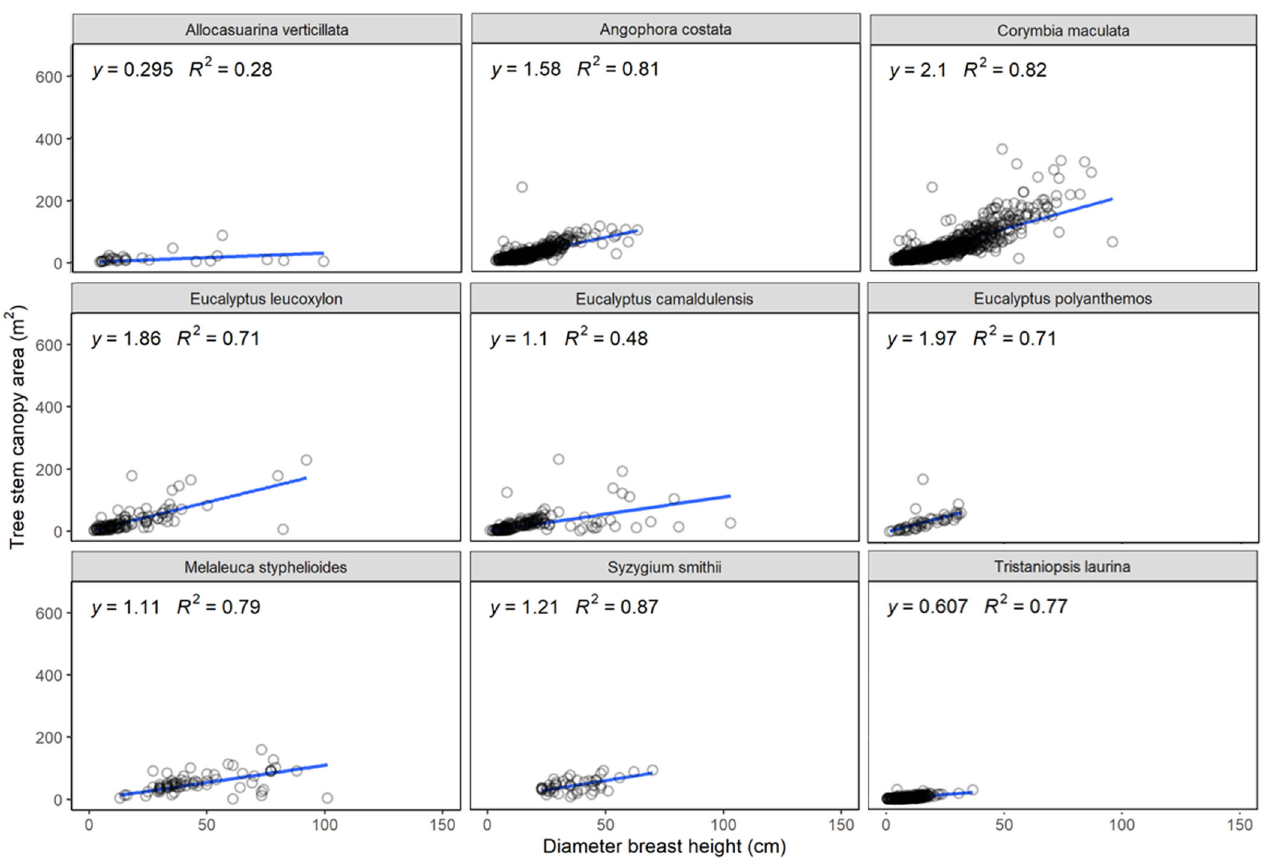
Fig. 6 Tree canopy growth projection using linear regression. Relationships between tree DBH and canopy of mature trees in the City of Melbourne, plotted for each of the nine species used in this